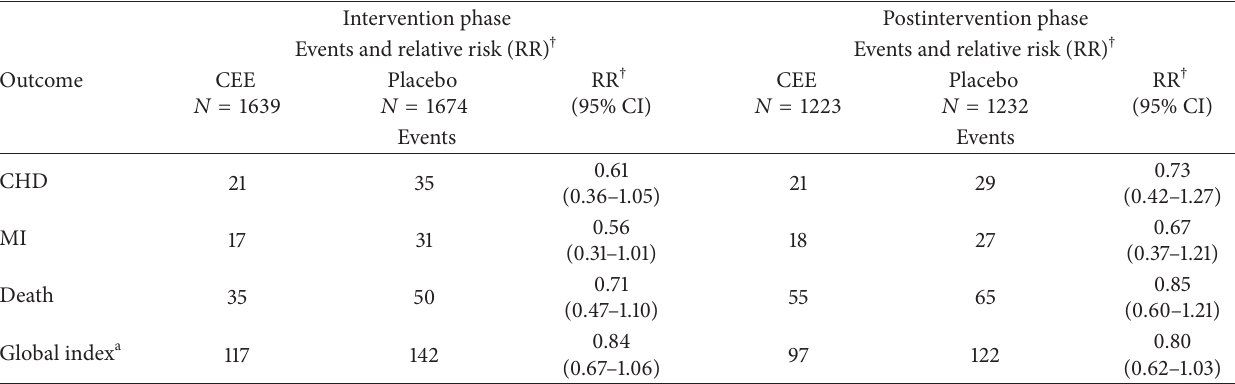
Table 4: Women 50–59 years of age at trial entry, WHI Estrogen-Alone Trial Outcomes, intervention phase and postintervention phase, events, and relative